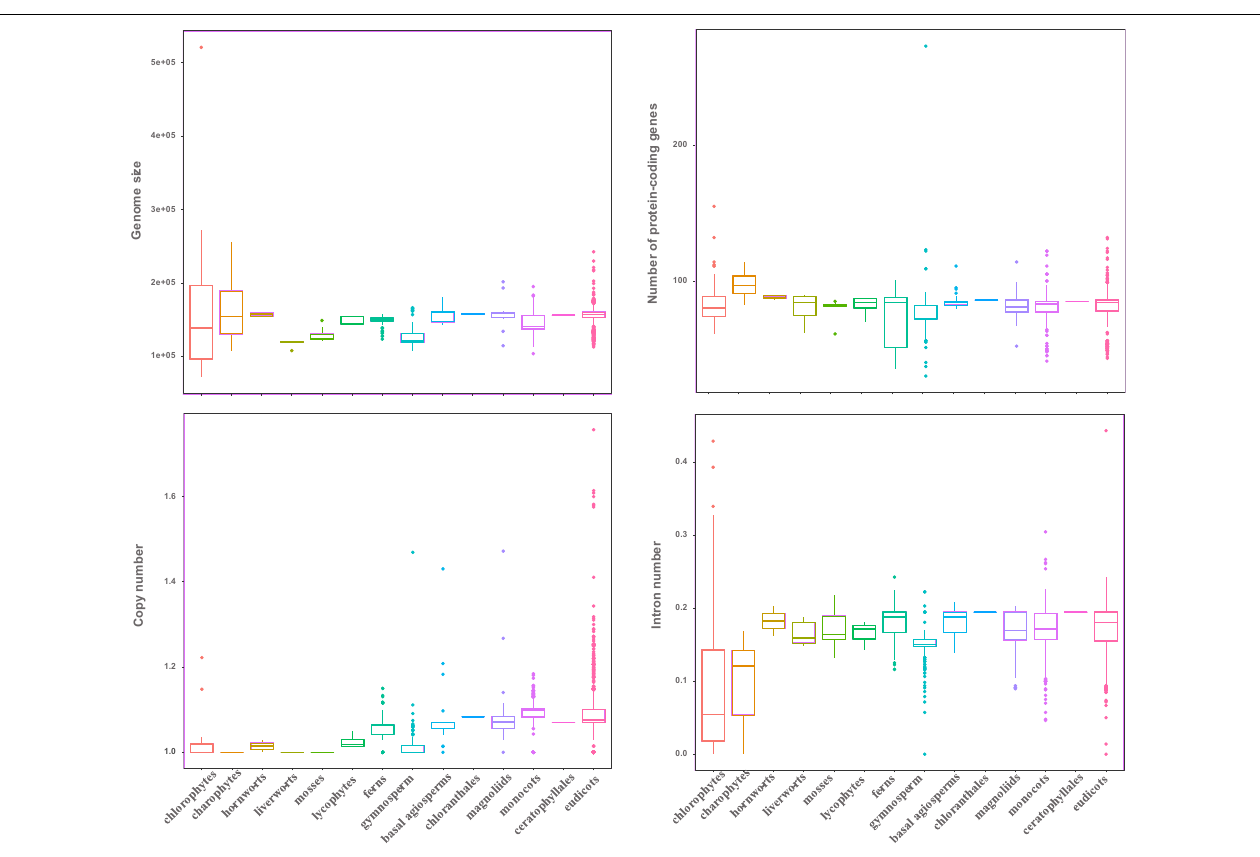
FIGURE 1 | Characteristic features of plastid genomes. The genome size, protein-coding genes number, gene copy number, and intron number in Viridiplantae. Boxplots represent minimum, median, and maximum values.